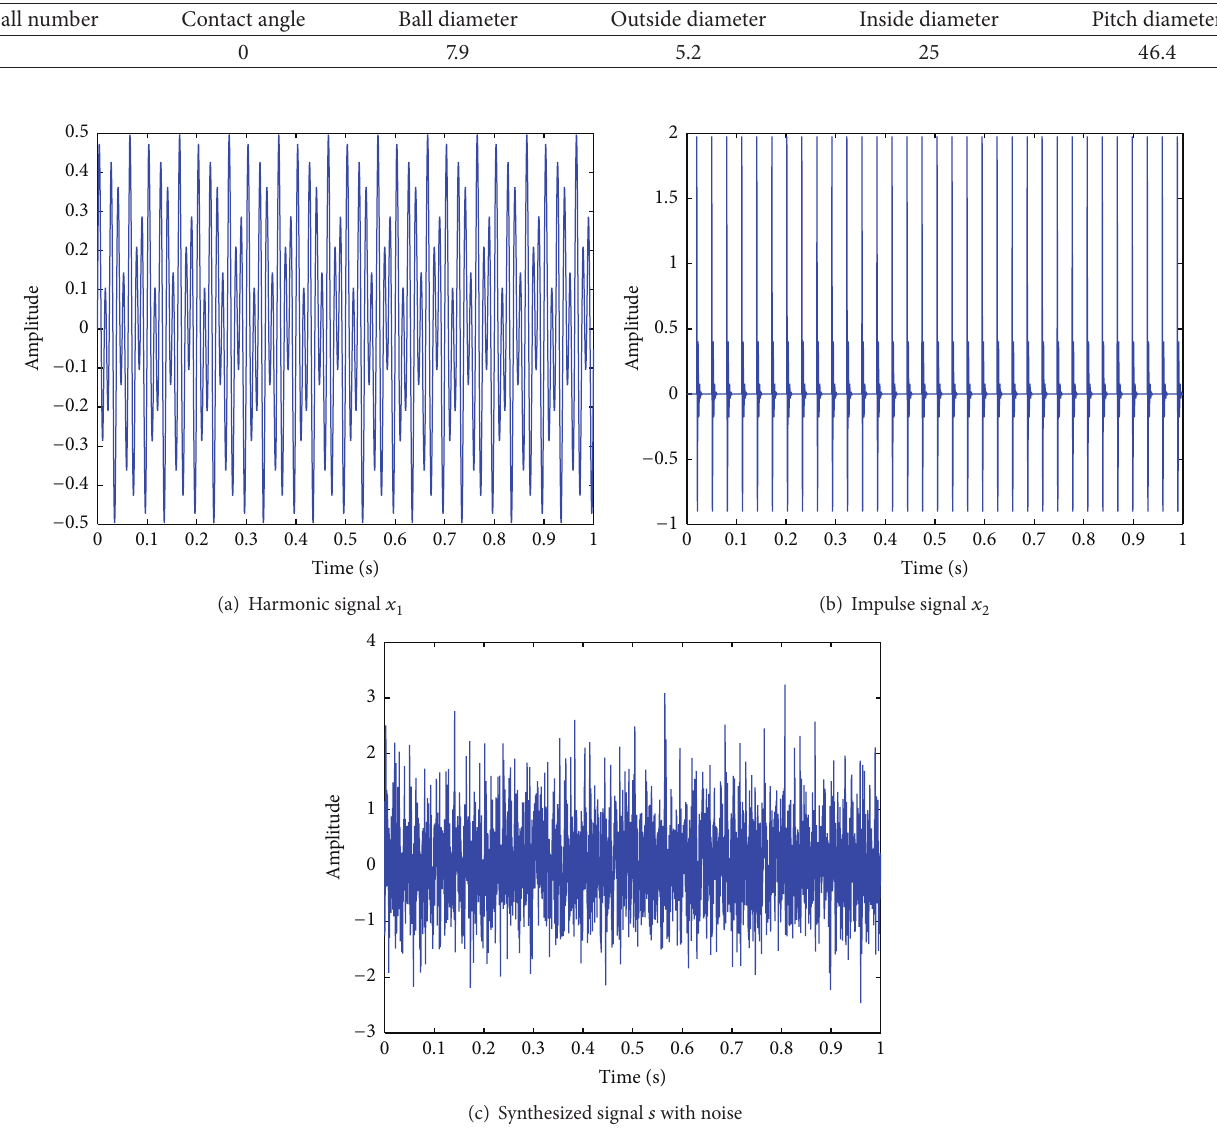
Table 1: The parameter of 6205-2RS JEM SKF (diameter/mm).